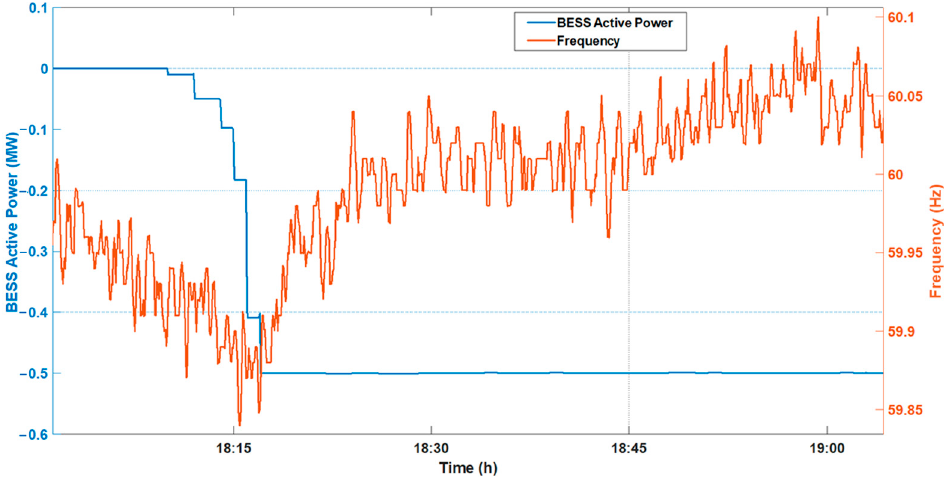
Figure 16. Frequency control performed by BESS. Measurement performed on 24 April 2021.